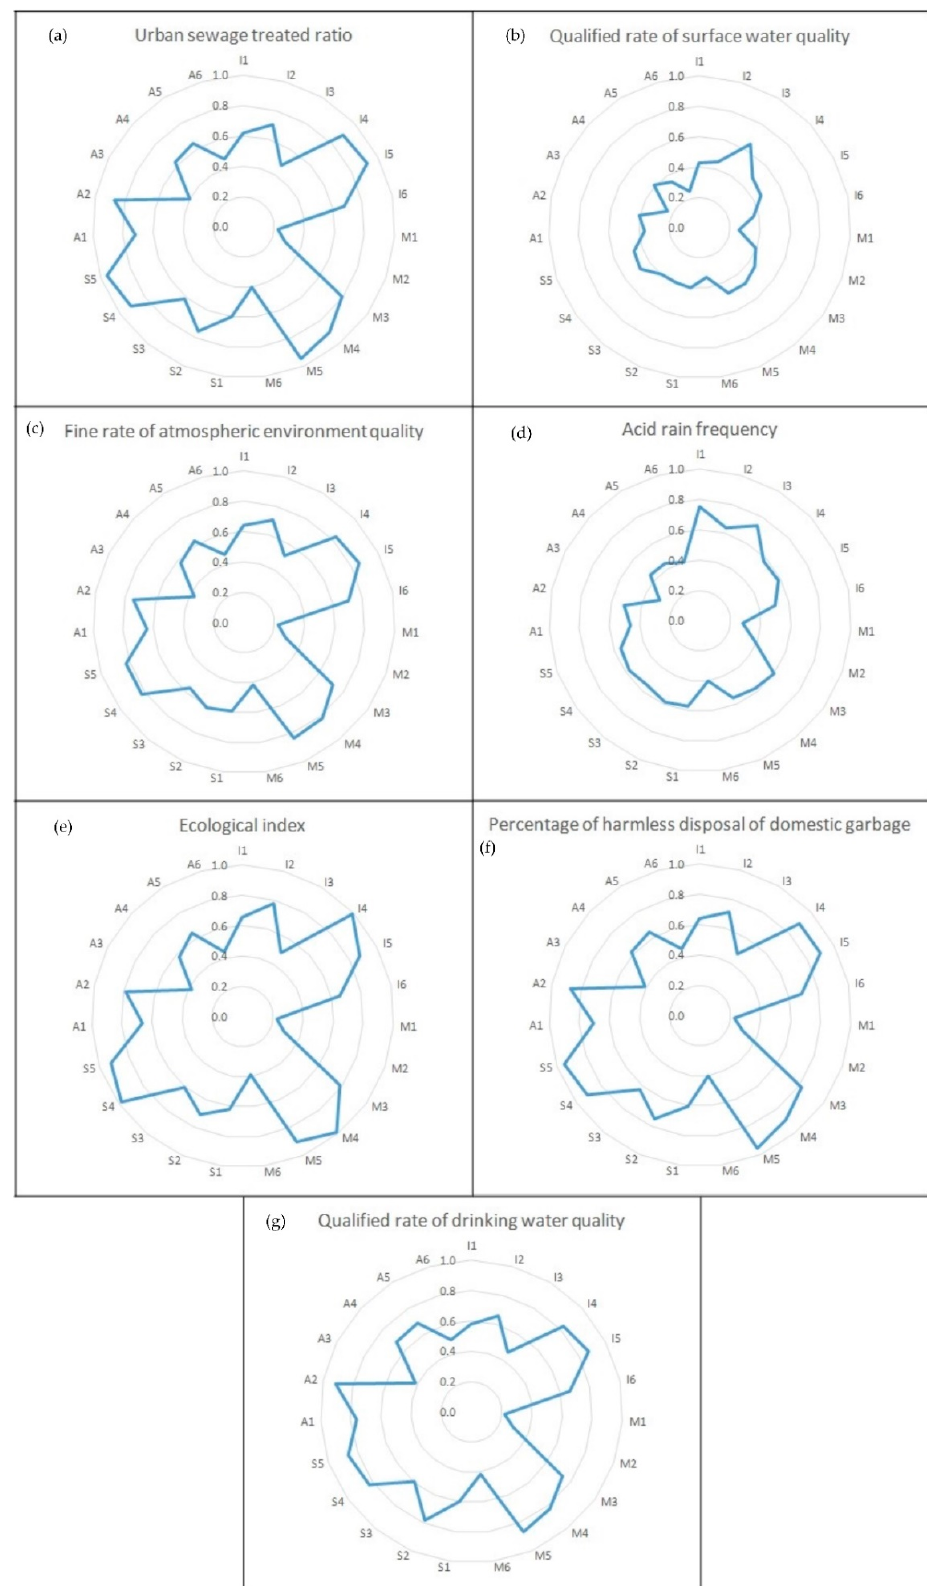
Figure 4. Contribution degree of QI attribute indices to (a) urban sewage treated ratio; (b) qualified rate of surface water quality; (c) fine rate of atmospheric environment quality; (d) acid rain frequency; (e) ecological index; (f) percentage of harmless disposal of domestic garbage; (g) qualified rate of drinking water quality in Shanghai.